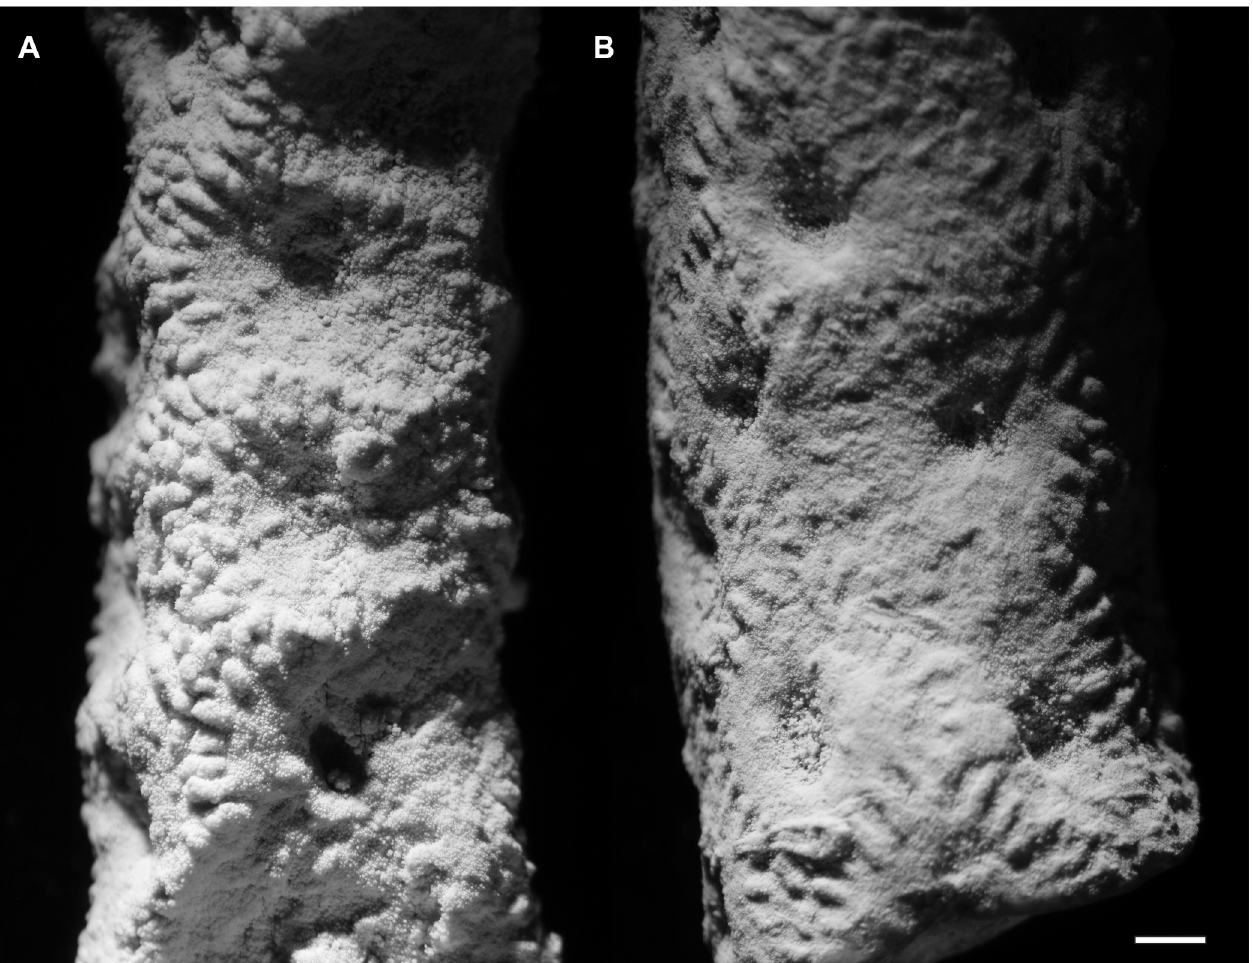
Fig 9. Thamnoptychia mistiaeni sp. nov. from Kowala Quarry, lithological sets J or K, Upper Famennian. (A) External view of a branch, specimen GIUS 3619 KF 090a (same as Fig 7C). (B) External view of a branch, specimen GIUS 3619 KF 090c (same as Fig 8A). Notice polygonal (subrectangular to subhexagonal) shape of